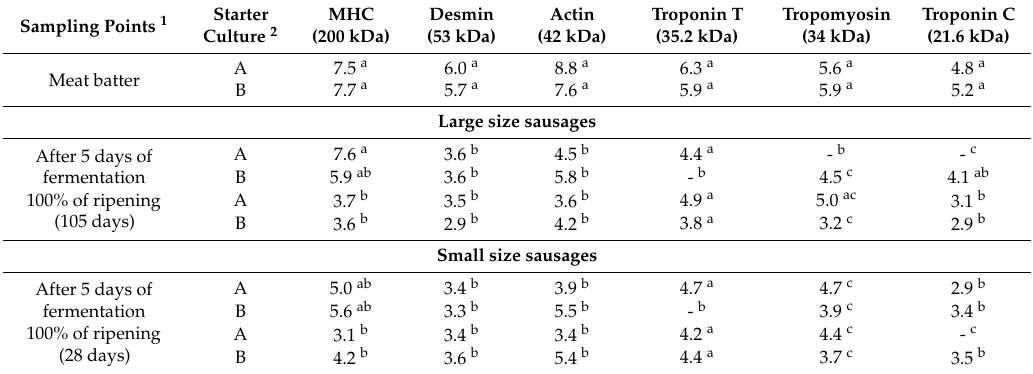
Table 2. Relative abundance (%) of the main myofibrillar proteins identified in the samples after 250 fermentation and ripening. The values are the mean of three independent samples. 251